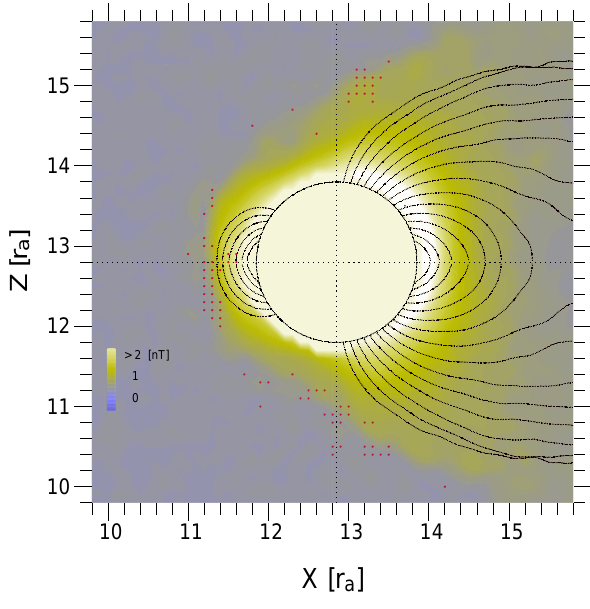
Fig. 1. Distribution of the number density of macroelectrons in the equatorial plane, at t =1s. The grid points where the current density is above 9nA/m 2 level, are marked in red. Number density unit is n o .